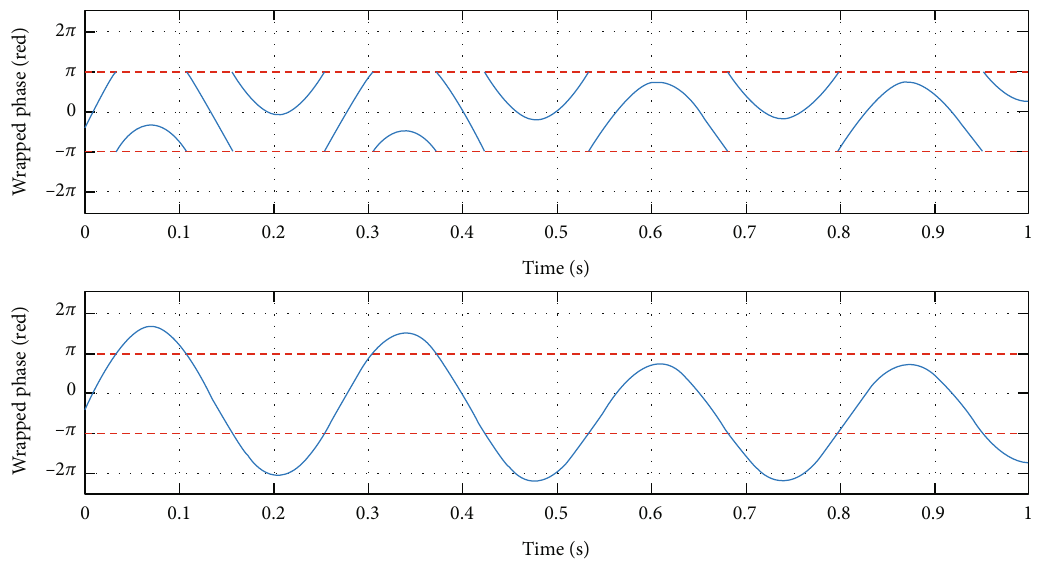
Figure 1: Illustration of original wrapped phase and unwrapped phase.